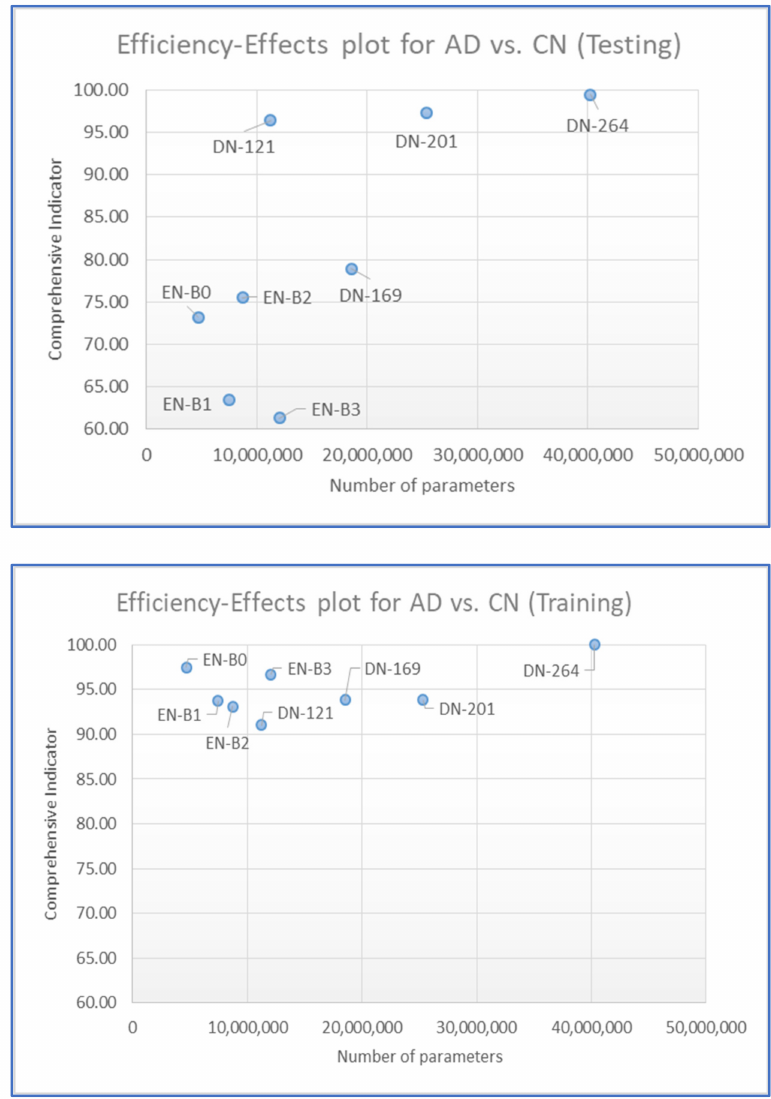
Figure 7. A comparison of the comprehensive performance indicators of eight deployed models for AD vs. CN